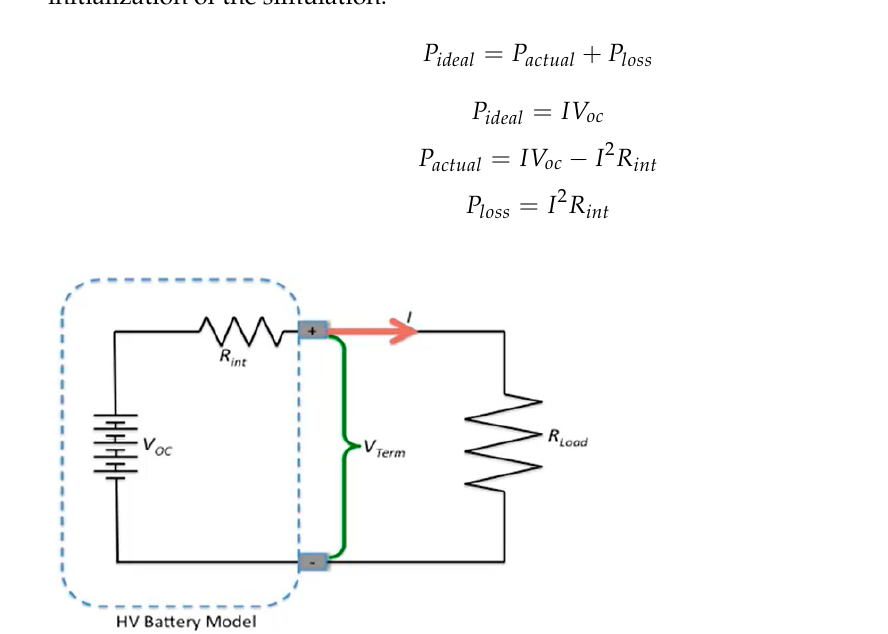
Figure 12. Battery model with internal resistance. Adapted from [16], MathWorks: 2020.